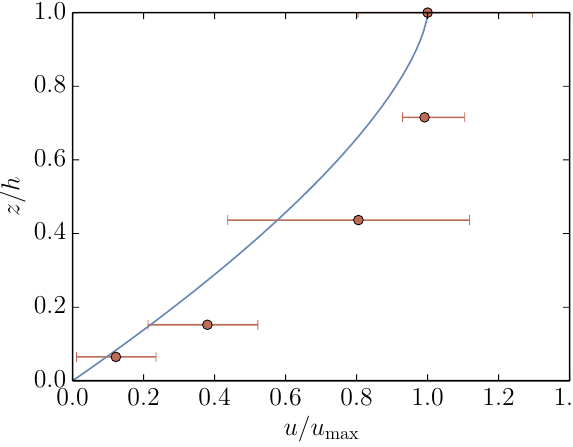
Figure 10. The factor λ as a function of σ and ˙ γ . In the white area no solutions could be obtained with the model. In the yellow area the value for the factor λ has its maximum value of approximately 3 . 5 × 10 − 4 Pas 2 . This value decreases at the borders of the yellow area. In the gray area, values for λ are negative, indicating a non- monotonic behavior.